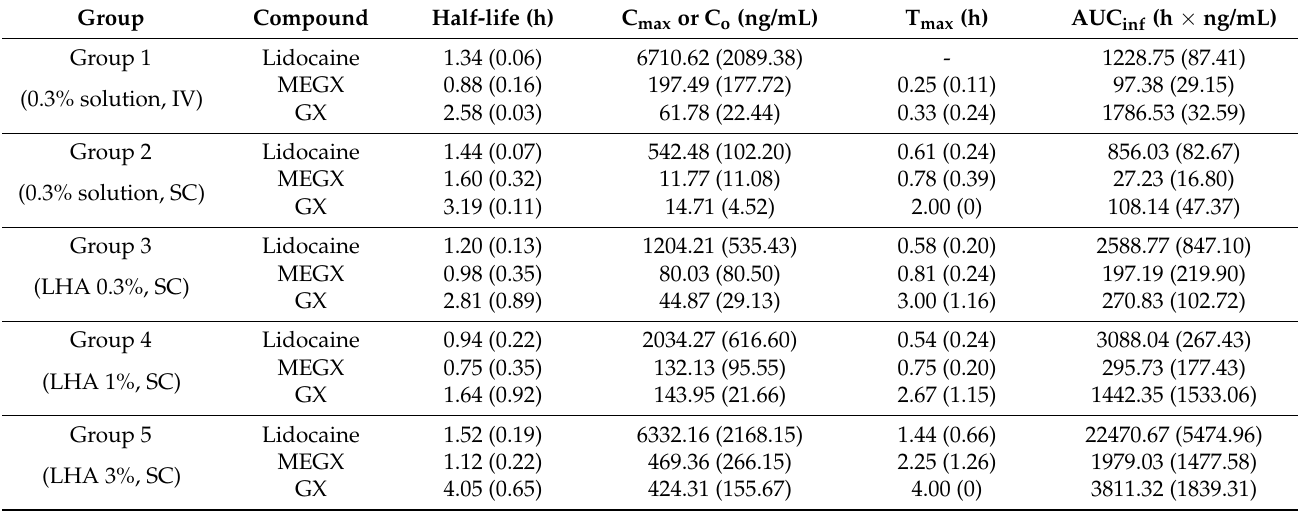
Table 3. Pharmacokinetic parameters of lidocaine, MEGX and GX (Mean, (S.D.)).